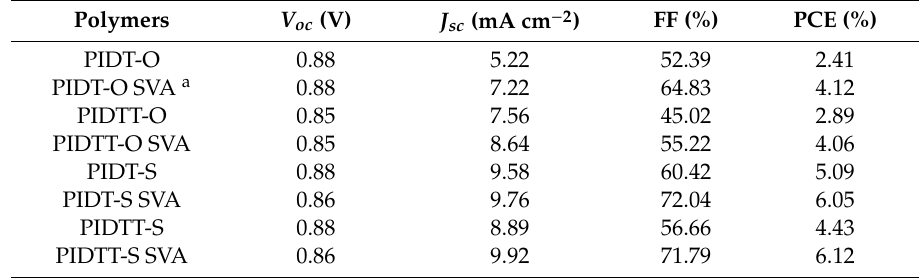
Table 4. Photovoltaic performances of PSCs based on PIDT-O, PIDTT-O, PIDT-S and PIDTT-S under the illumination of AM 1.5 G, 100 mW cm − 2